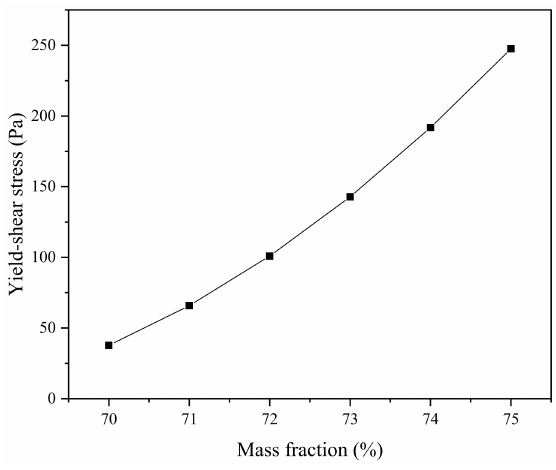
Figure 19. Fitting curve of yield shear stress.